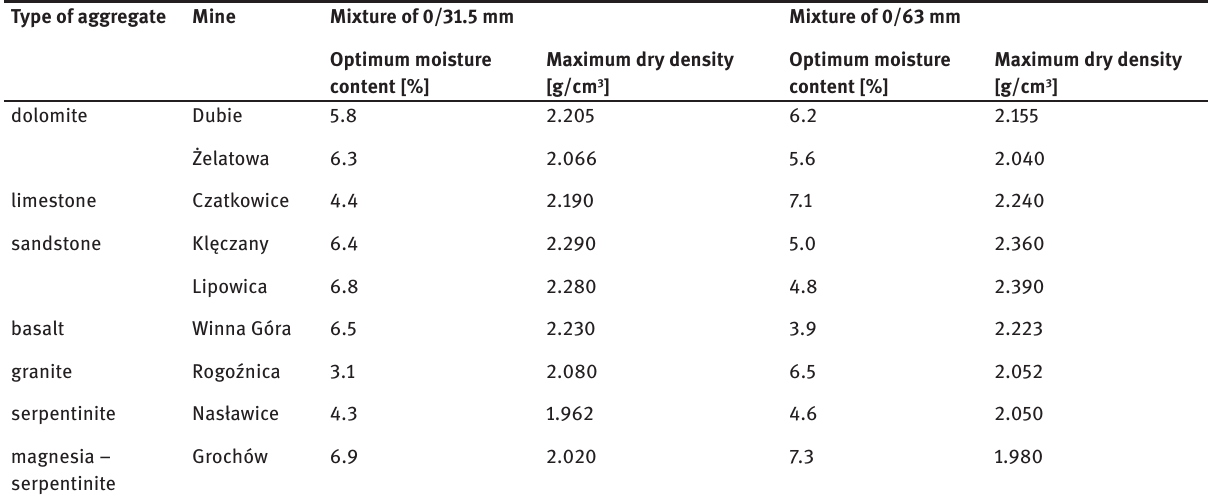
Table 3: Optimum moisture content and maximum dry density for tested samples. Type of